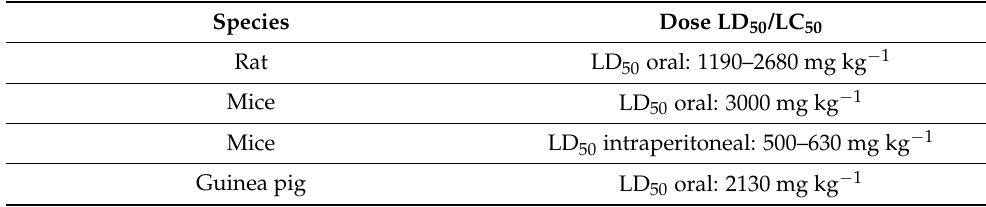
Table 2. LD 50 values of eugenol in laboratory